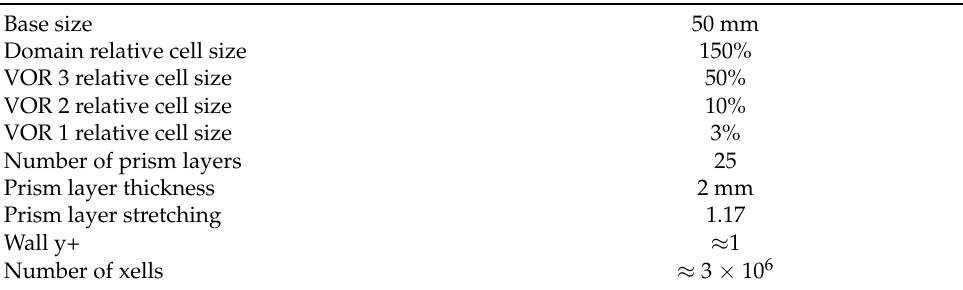
Table 2. Mesh parameters.